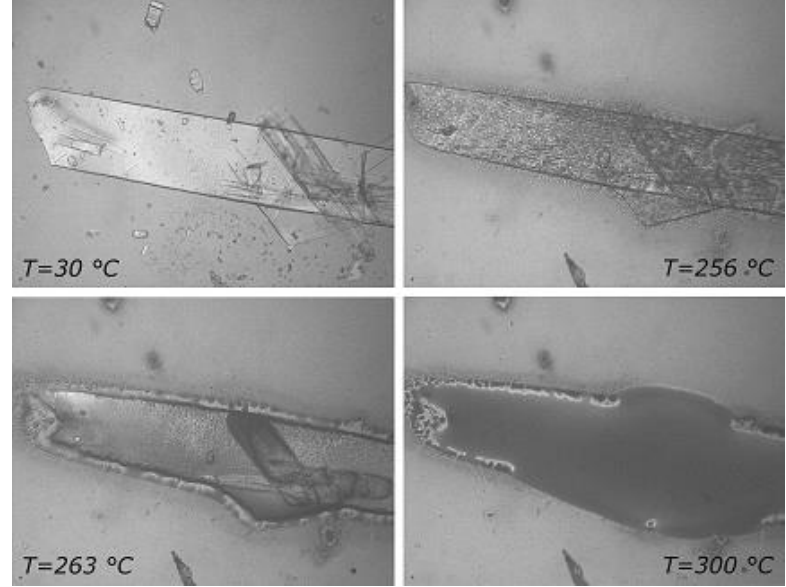
Figure 3. HSM images of RSV recrystallized from methanol–water solution, at the various temperatures reported on the images.